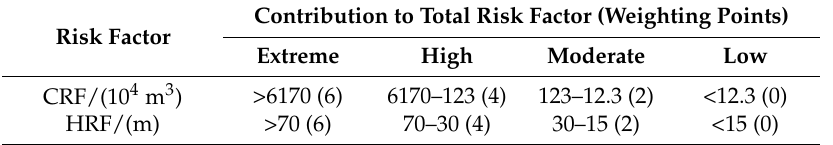
Table 1. Definition of dam size risk factors.